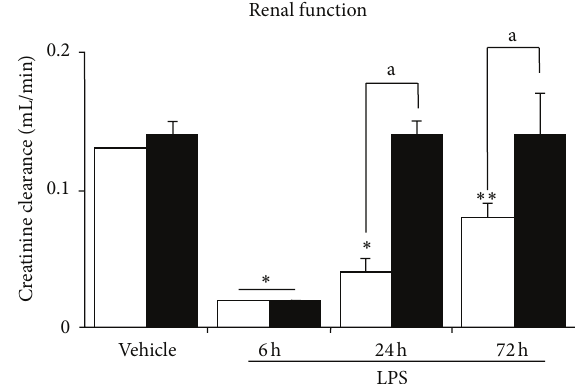
Figure2:Renalfunction(endogenouscreatinineclearance(CCr)in diabetic(blackbars)andnondiabetic(openbars)LPS-injectedmice. Values are mean ± SEM. ∗ 𝑃 < 0.05 versus control value, ∗∗ 𝑃 < 0.01 versus control value, and a 𝑃 < 0.01 versus